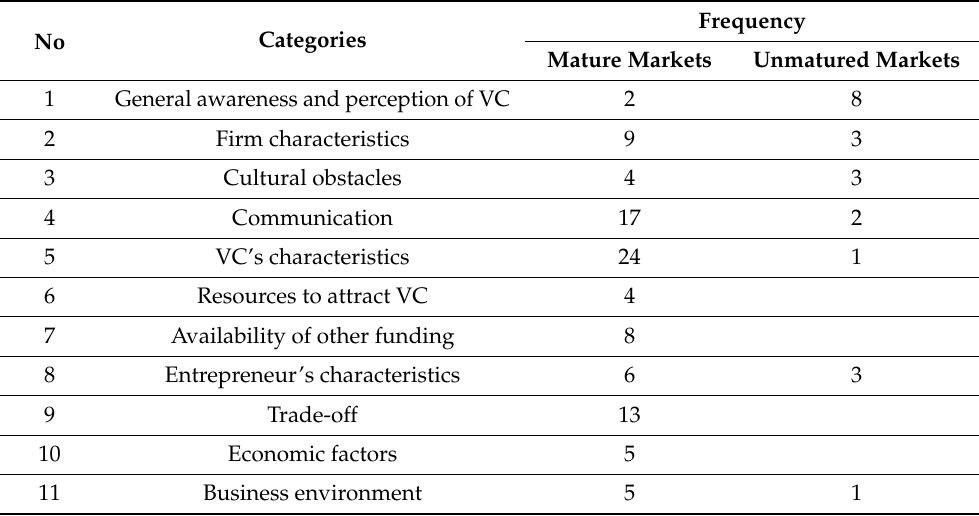
Table 6. The factors influencing cooperation between venture capitalists and